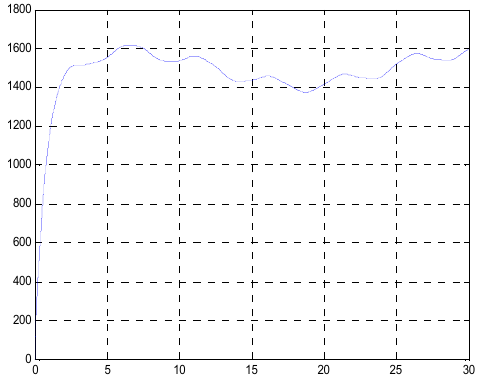
Figure 3. Mechanical speed (tr/min).